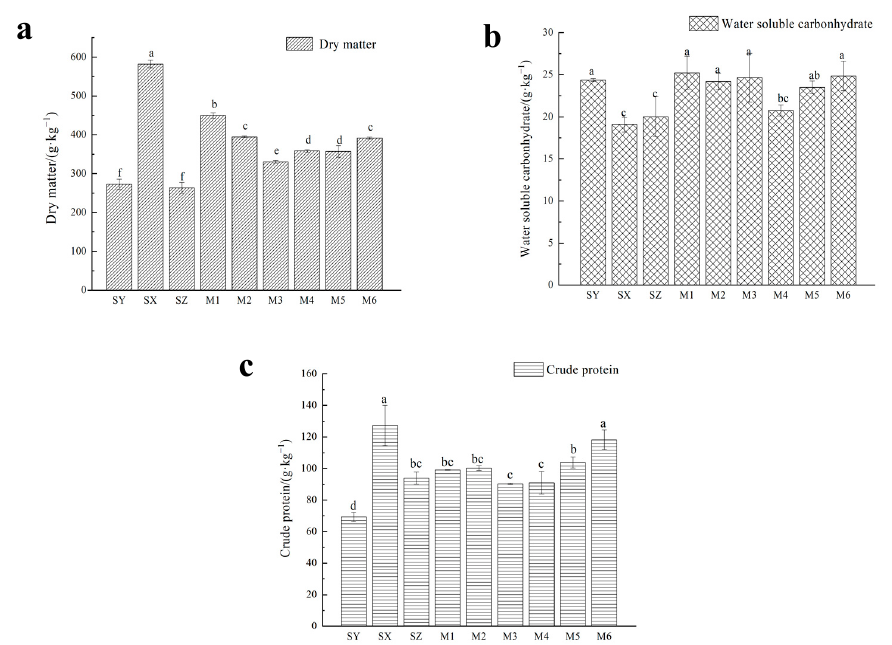
Figure 2. Contents of DM ( a ), WSC ( b ) and CP ( c ) after mixed silage of rapeseed with alfalfa or Myriophyllum spicatum in different proportions. Note: Different lowercase letters indicate significant difference between different treatment groups ( p < 0.05). The same below.